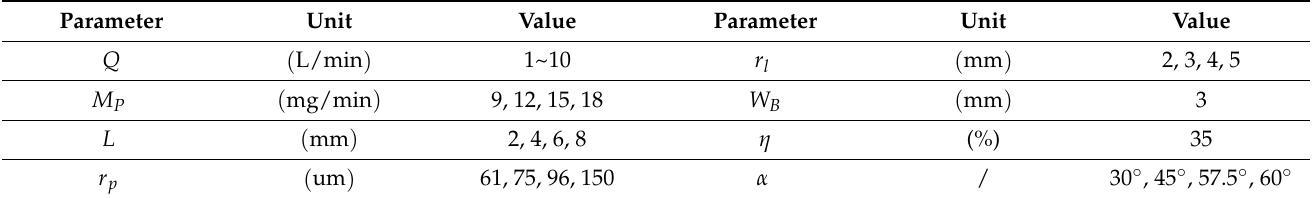
Table 1. Material properties used in the